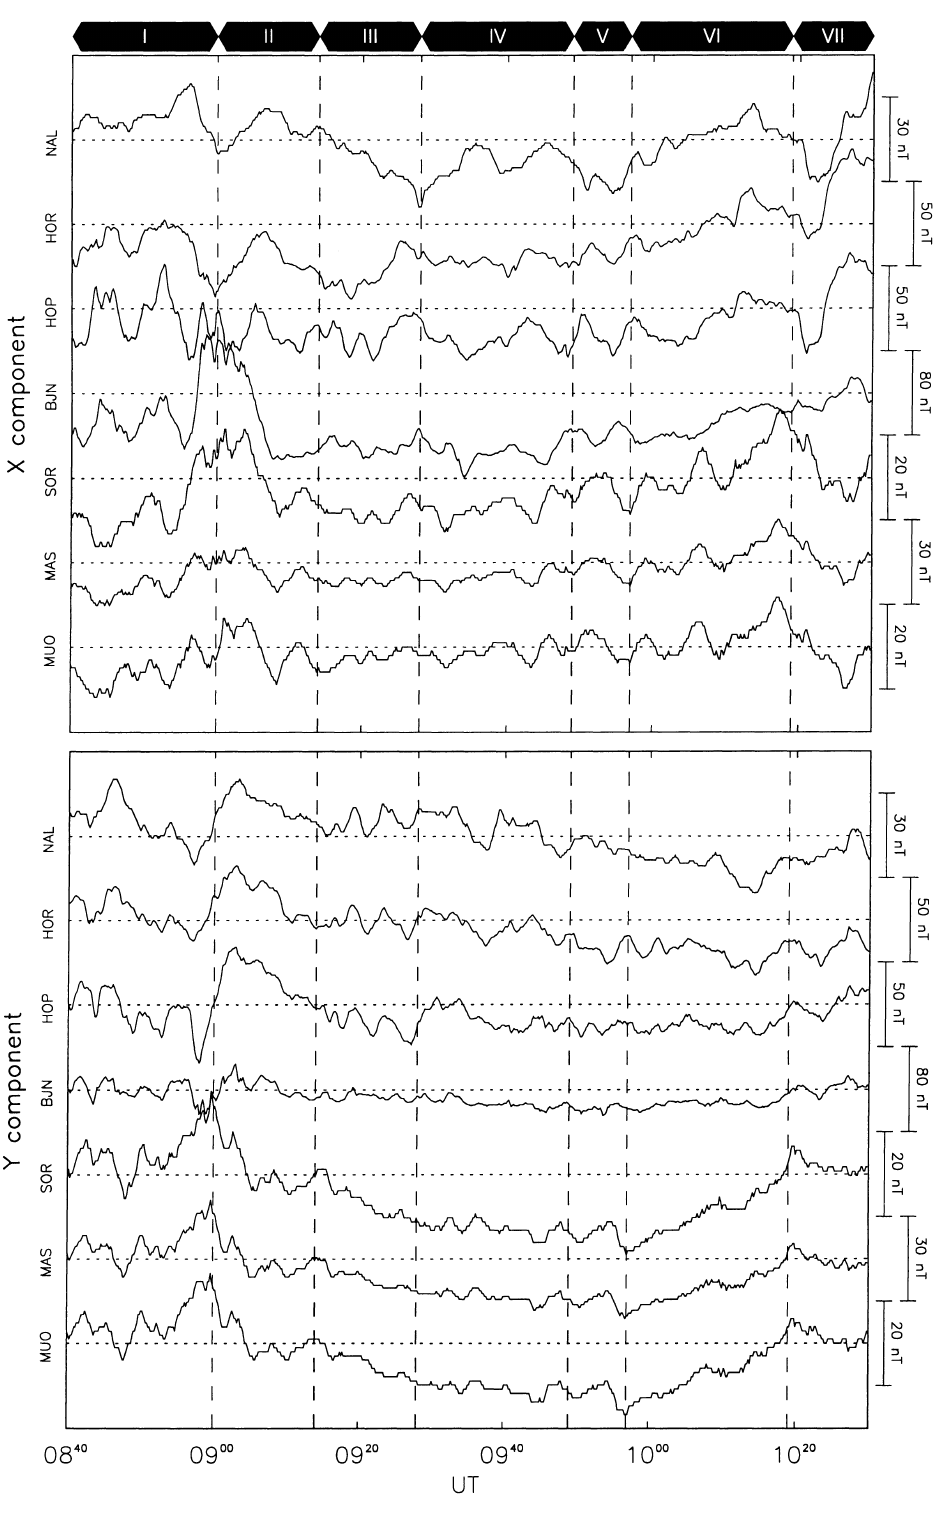
Fig. 7. X and Y component magnetograms from the IM- AGE stations NAL, HOR, HOP, BJN, SOR, MAS, and MUO, for the period 0840 UT to 1030 UT on 17